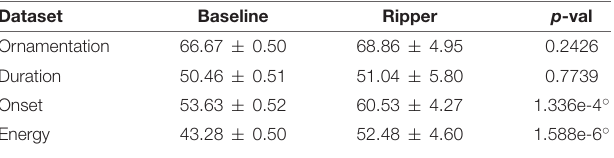
TABLE 7 | Accuracy of models trained with all extracted features (Mean ± Std Dev).